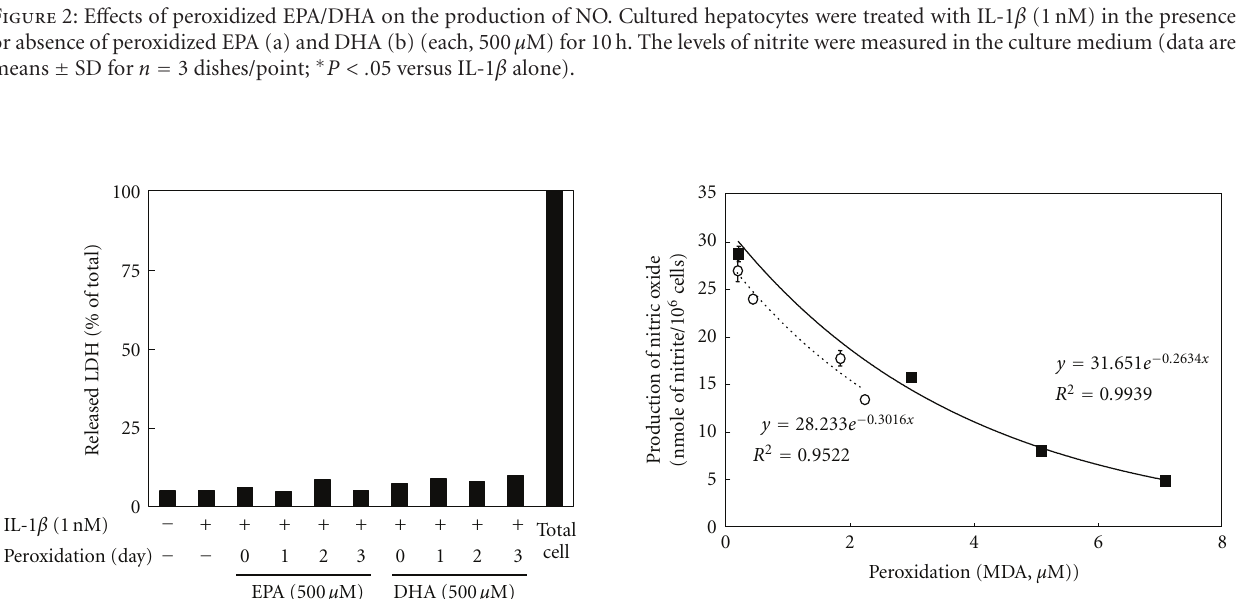
Figure 3: E ff ects of peroxidized EPA/DHA on cellular cytotoxicity. Cells were treated with IL-1 β (1nM) in the presence or absence of peroxidized EPA and DHA (each, 500 μ M) for 10h. The LDH activities were measured in the culture medium (data are means ± SD for n = 3 dishes/point).